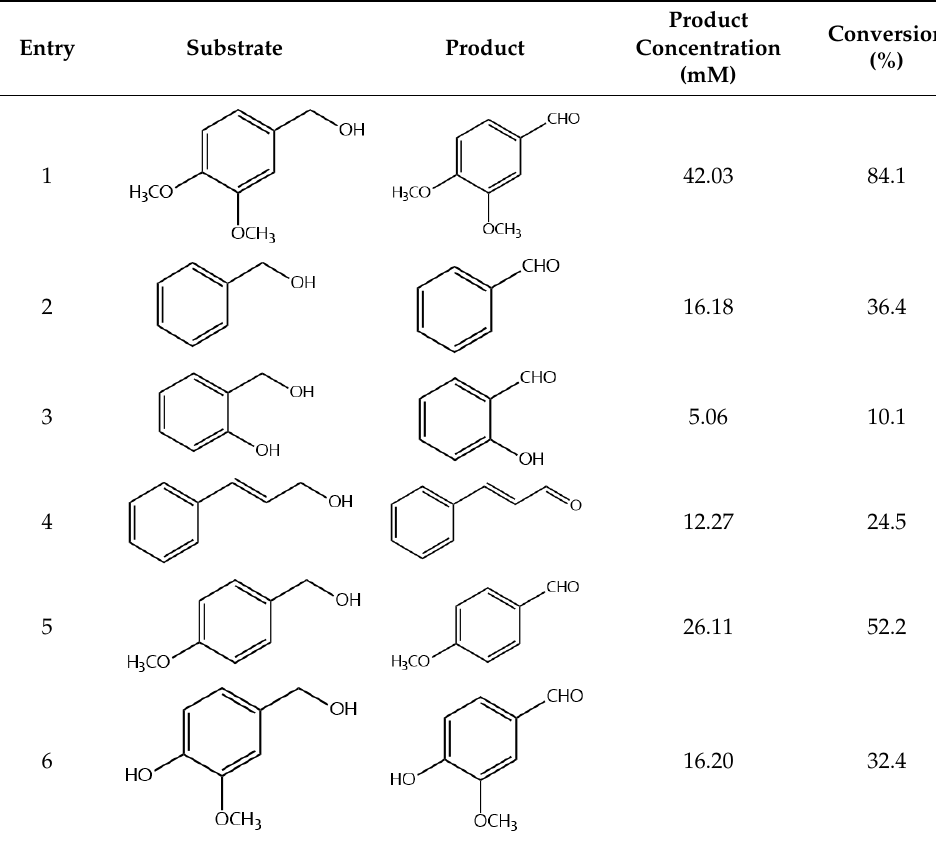
Table 1. Substrate expansion studies 1 .